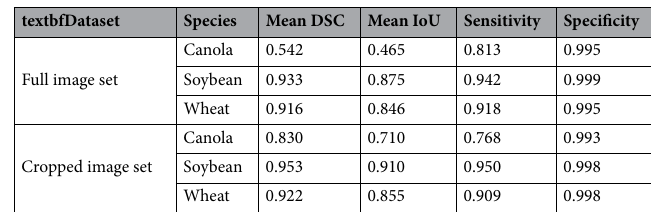
Table 6. Per-species breakdown of results on the validation